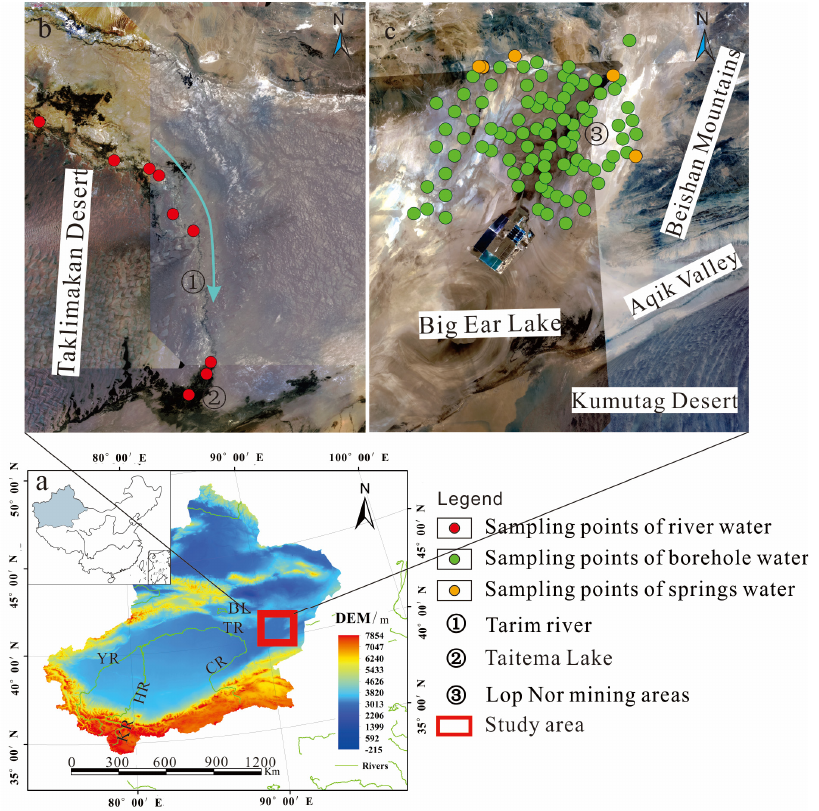
Figure 1. Location of the Lop Nor basin in China and the distribution of sampling points of this study; ( a ) shows the elevation of Xin Jiang Province and the approximate location of the Lop Nor Basin; ( b ) shows the sampling points along Tarim River; ( c ) shows the sampling points in the Lop Nor Basin. YR—Yarkand River; BL—Boston Lake; TR—Tarim River; CR—Cherchen River; HR—Hetian River. → shows the stream direction of Tarim